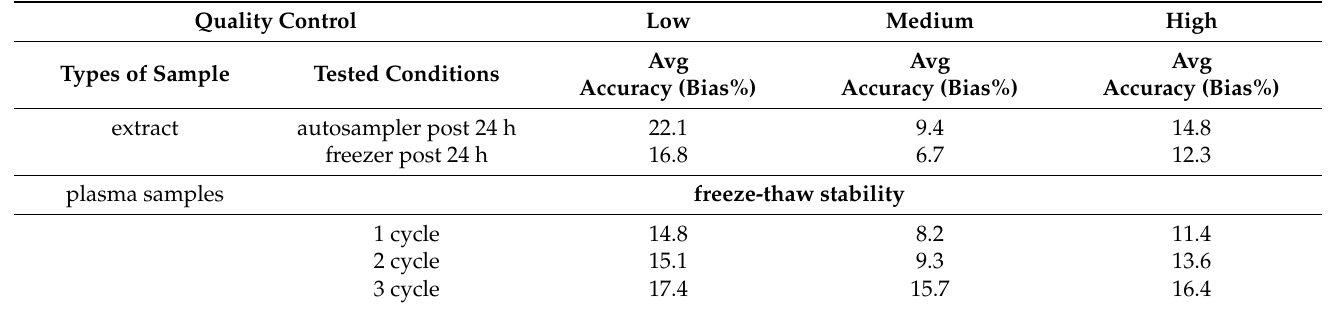
Table 5. Stability of DBV at different storage conditions. In our study, we tested both the extracts and the plasma samples (according to routine